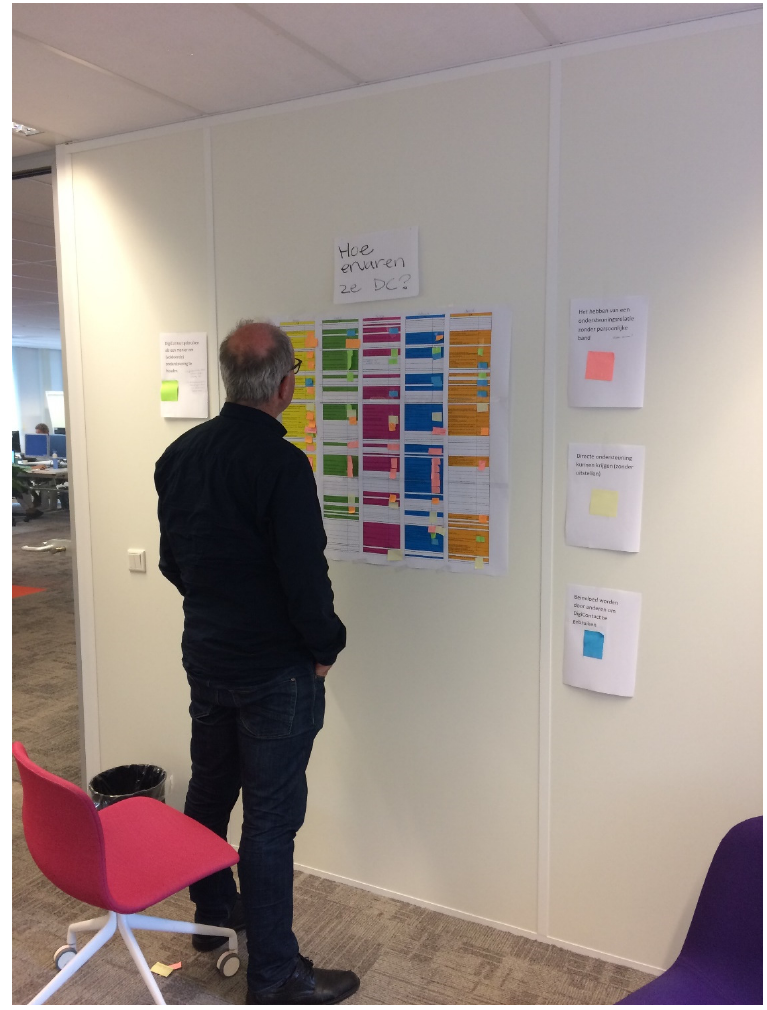
Figure 4. An analysis session of Mark and Miriam (3 June 2019).